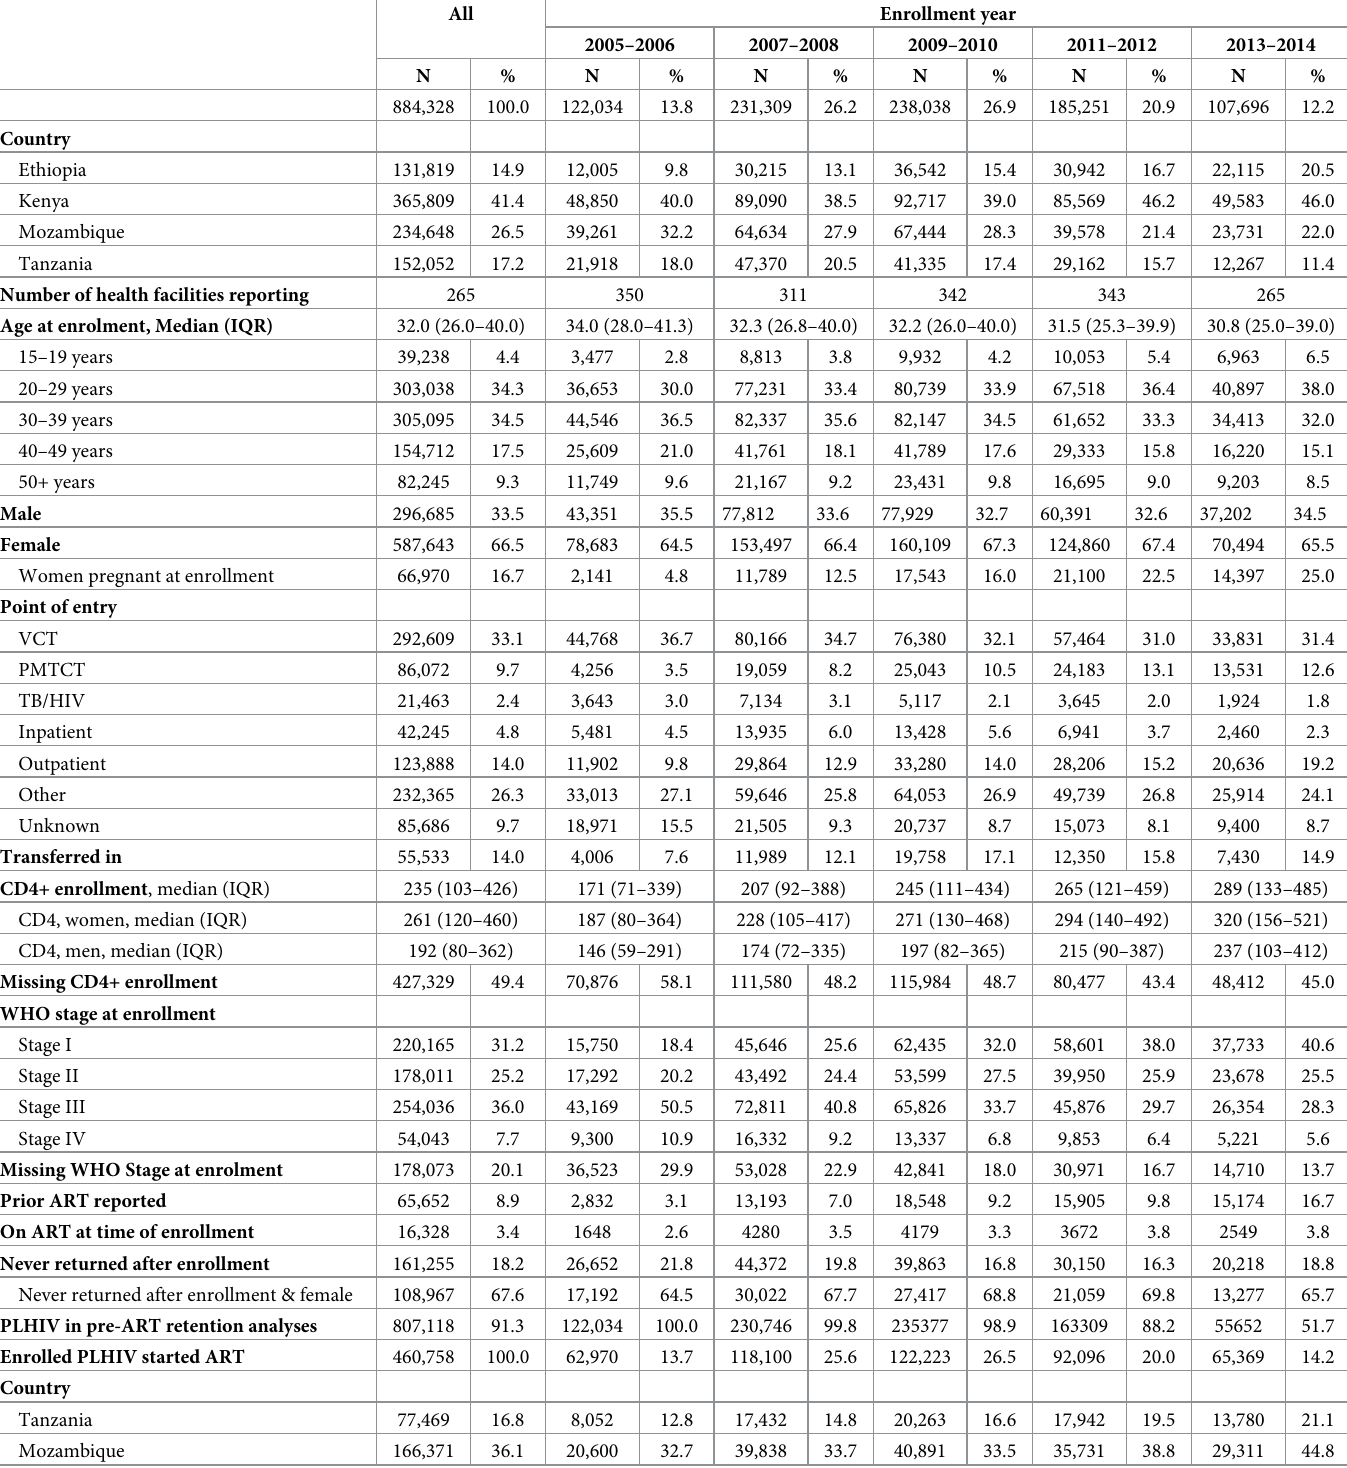
Table 1. Characteristics at enrollment in HIV care and at ART initiation among adults ( > = 15 years) living with HIV enrolled in care at ICAP-supported facilities in Ethiopia, Kenya, Mozambique and Tanzania 2005–2014 (N = 884,328).